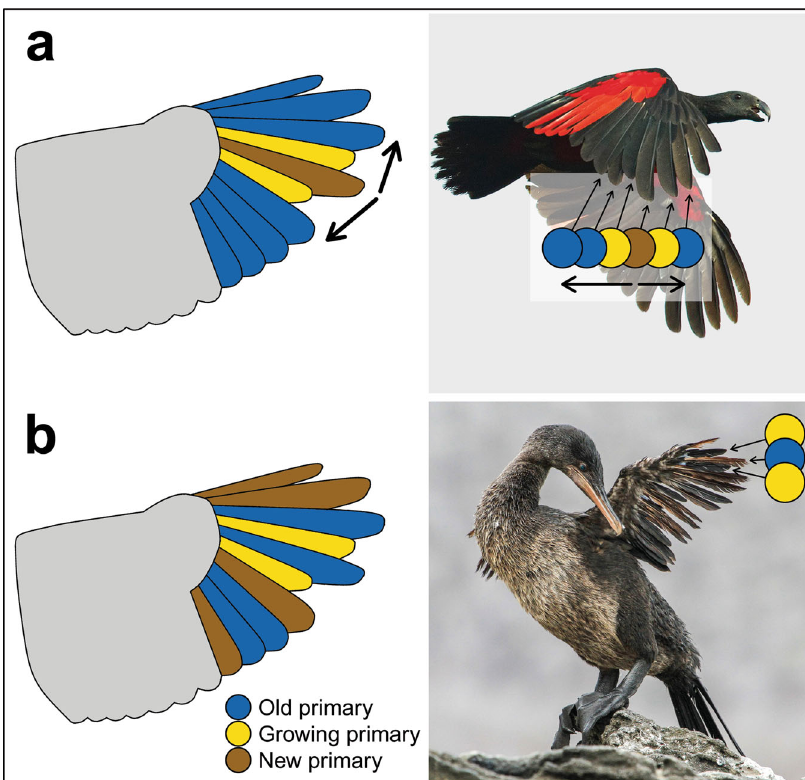
Fig. 1 Two optional molt strategies fi t a situation of two single feathers in growth in mid-primary feathers. a Bidirectional sequence, a sequential molt strategy starting with the molt of a mid-primary and progressing inward and outward. This strategy is rare among modern birds but typical of parrots and falcons, for example, the Pesquet ’ s Parrot ( Psittrichas fulgidus ; Credit: L. Petersson, ML205975001, The Macaulay Library at the Cornell Lab of Ornithology). b Irregular, non-sequential molt, as occurs among fl ightless birds, for example, the Flightless Cormorant ( Phalacrocorax harrisi ; Credit: L. Martin). This individual demonstrates the possibility of two single molting feathers (probably P5 and P7, P6 is old) when non-sequential molt